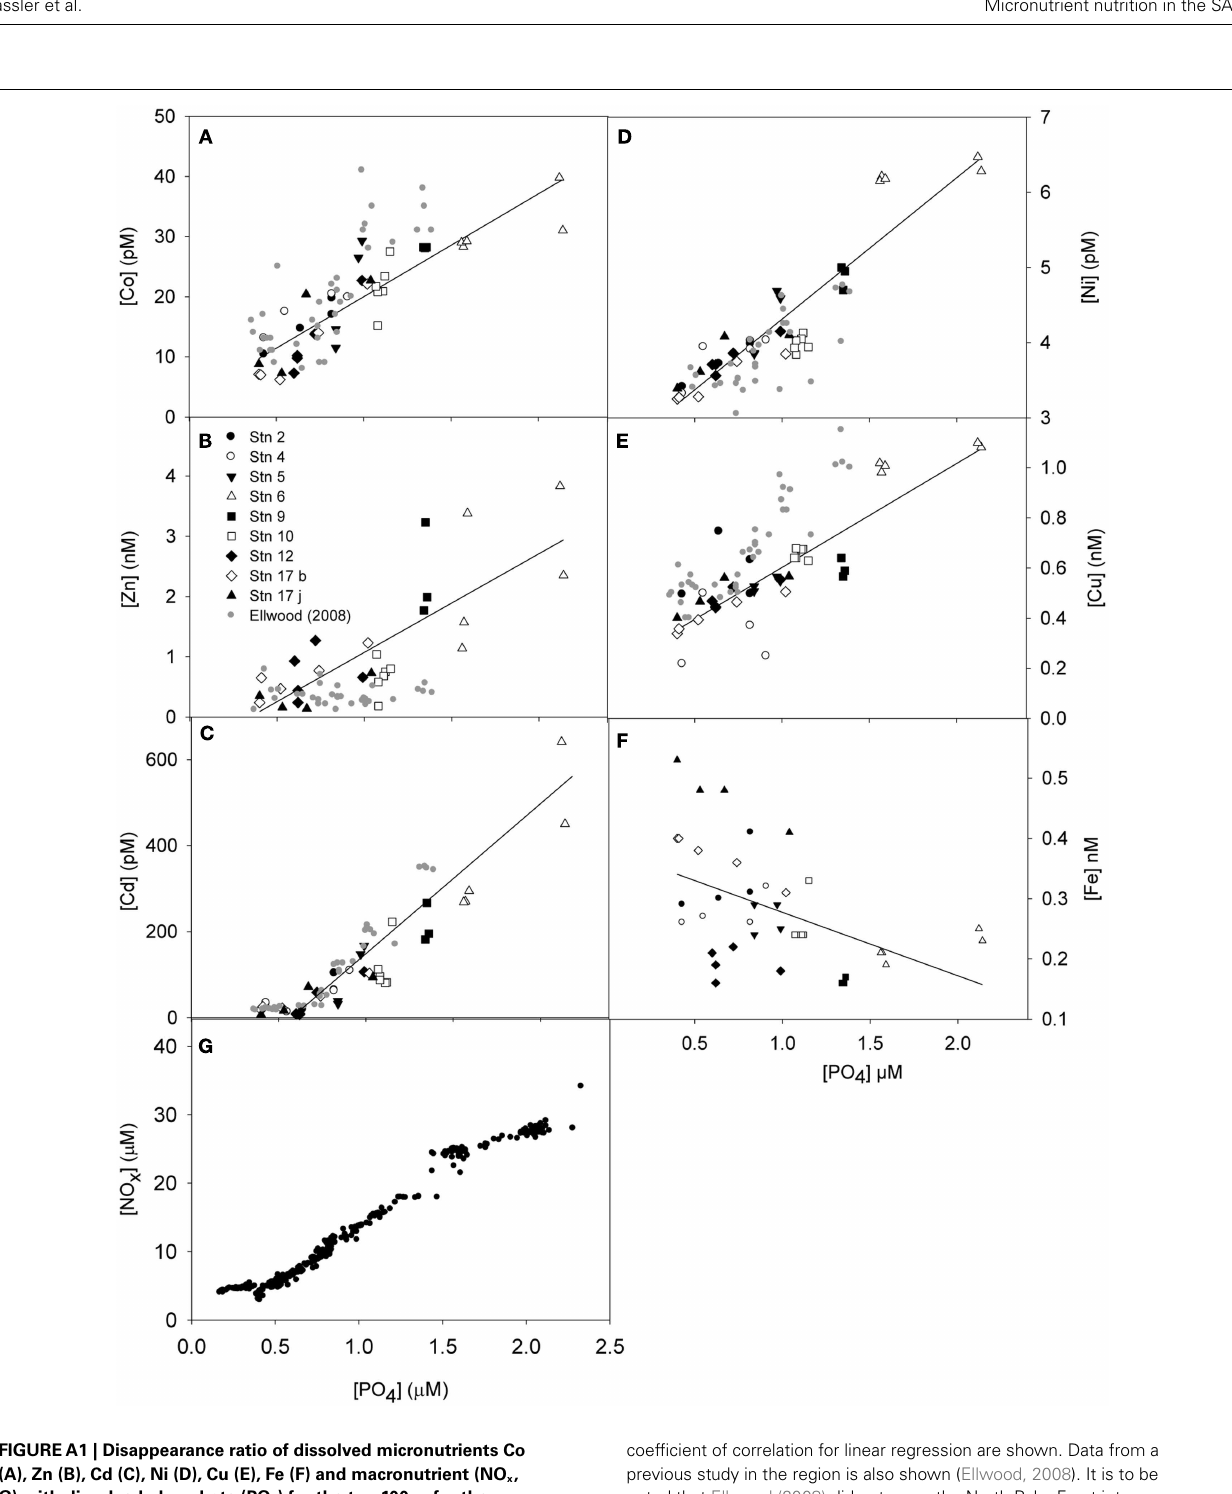
FIGUREA1 | Disappearance ratio of dissolved micronutrients Co (A), Zn (B), Cd (C), Ni (D), Cu (E), Fe (F) and macronutrient (NO x , G) with dissolved phosphate (PO 4 ) for the top 100m for the Subantarctic and Polar Frontal Zone (Australian sector). Depths and stations are distinguished by different symbol.The slope and the